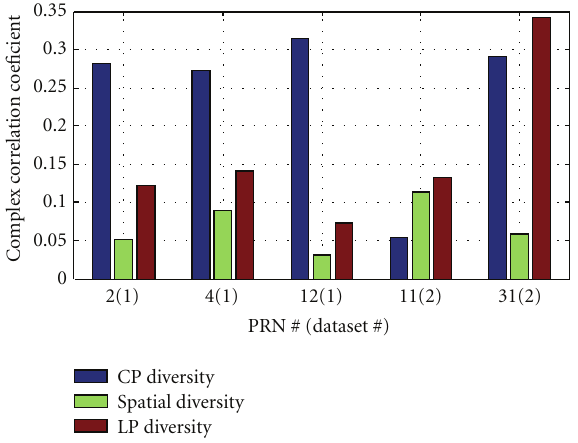
Figure 8: Correlation coe ffi cients between two diversity branches for di ff erent diversity structures.